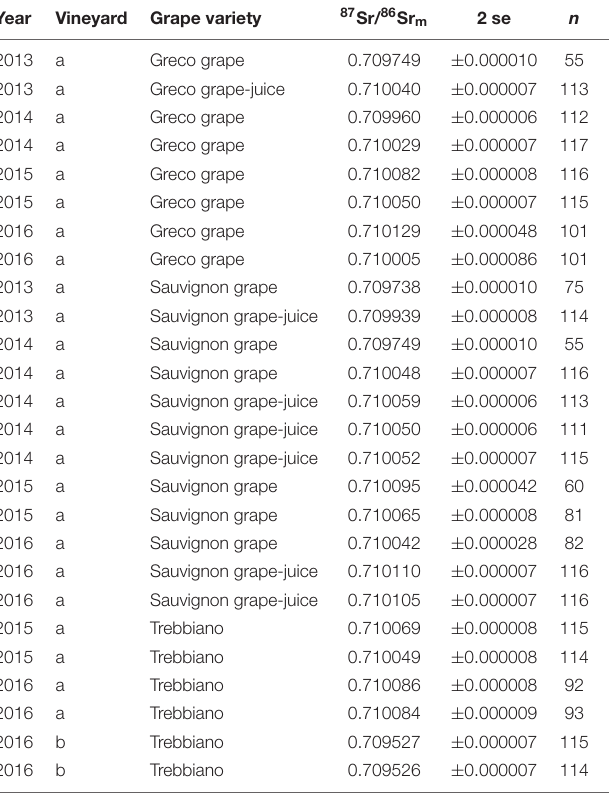
TABLE 2 | Isotopic composition of the grapes and grape-juices divided by vintage years and grape variety. Year Vineyard Grape variety